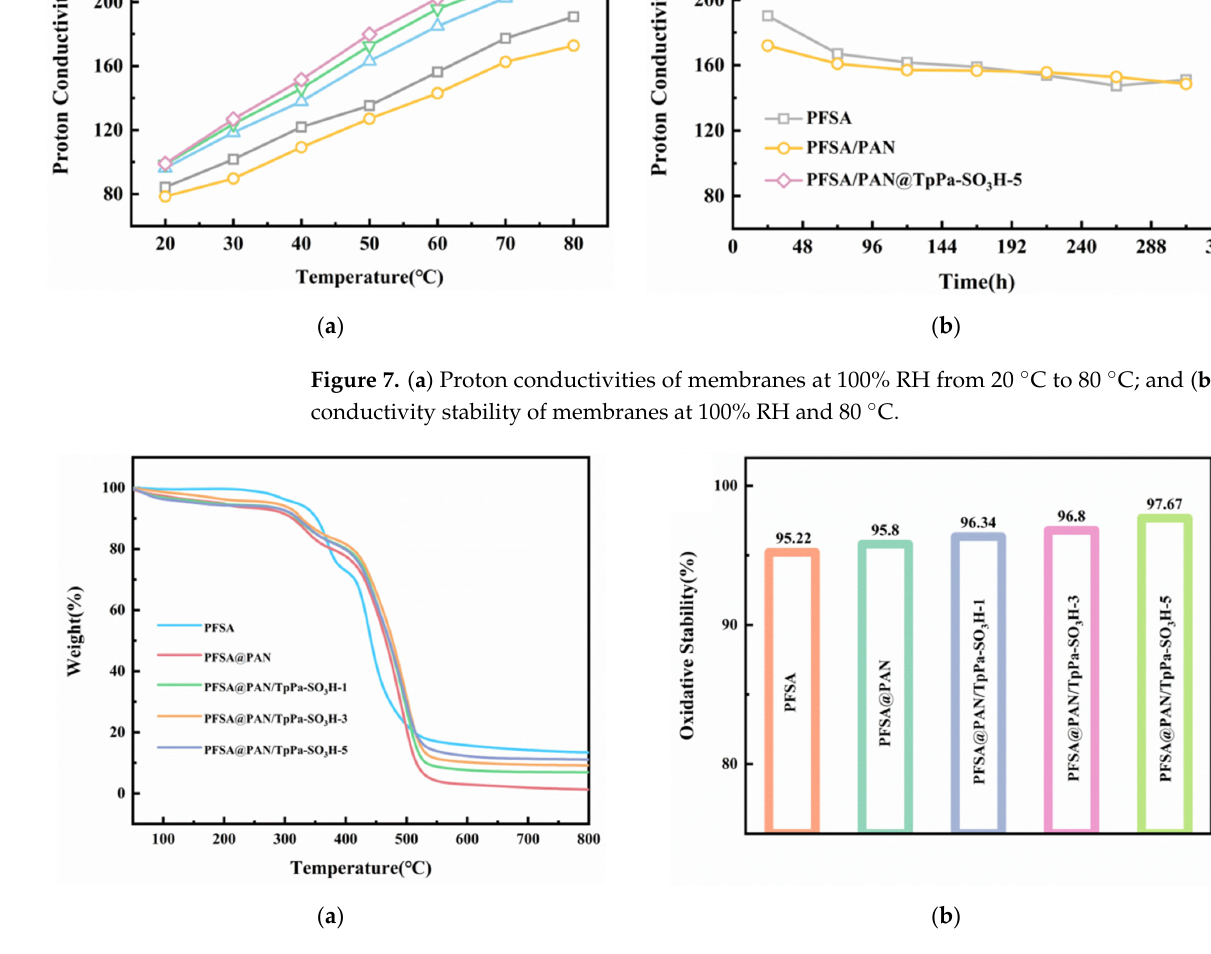
Figure 8. ( a ) Thermal stability of PFSA and fibrous composite membranes; ( b ) oxidative stability of PFSA, PFSA@PAN and PFSA@PAN/TpPa ‐ SO 3 H composite membranes.